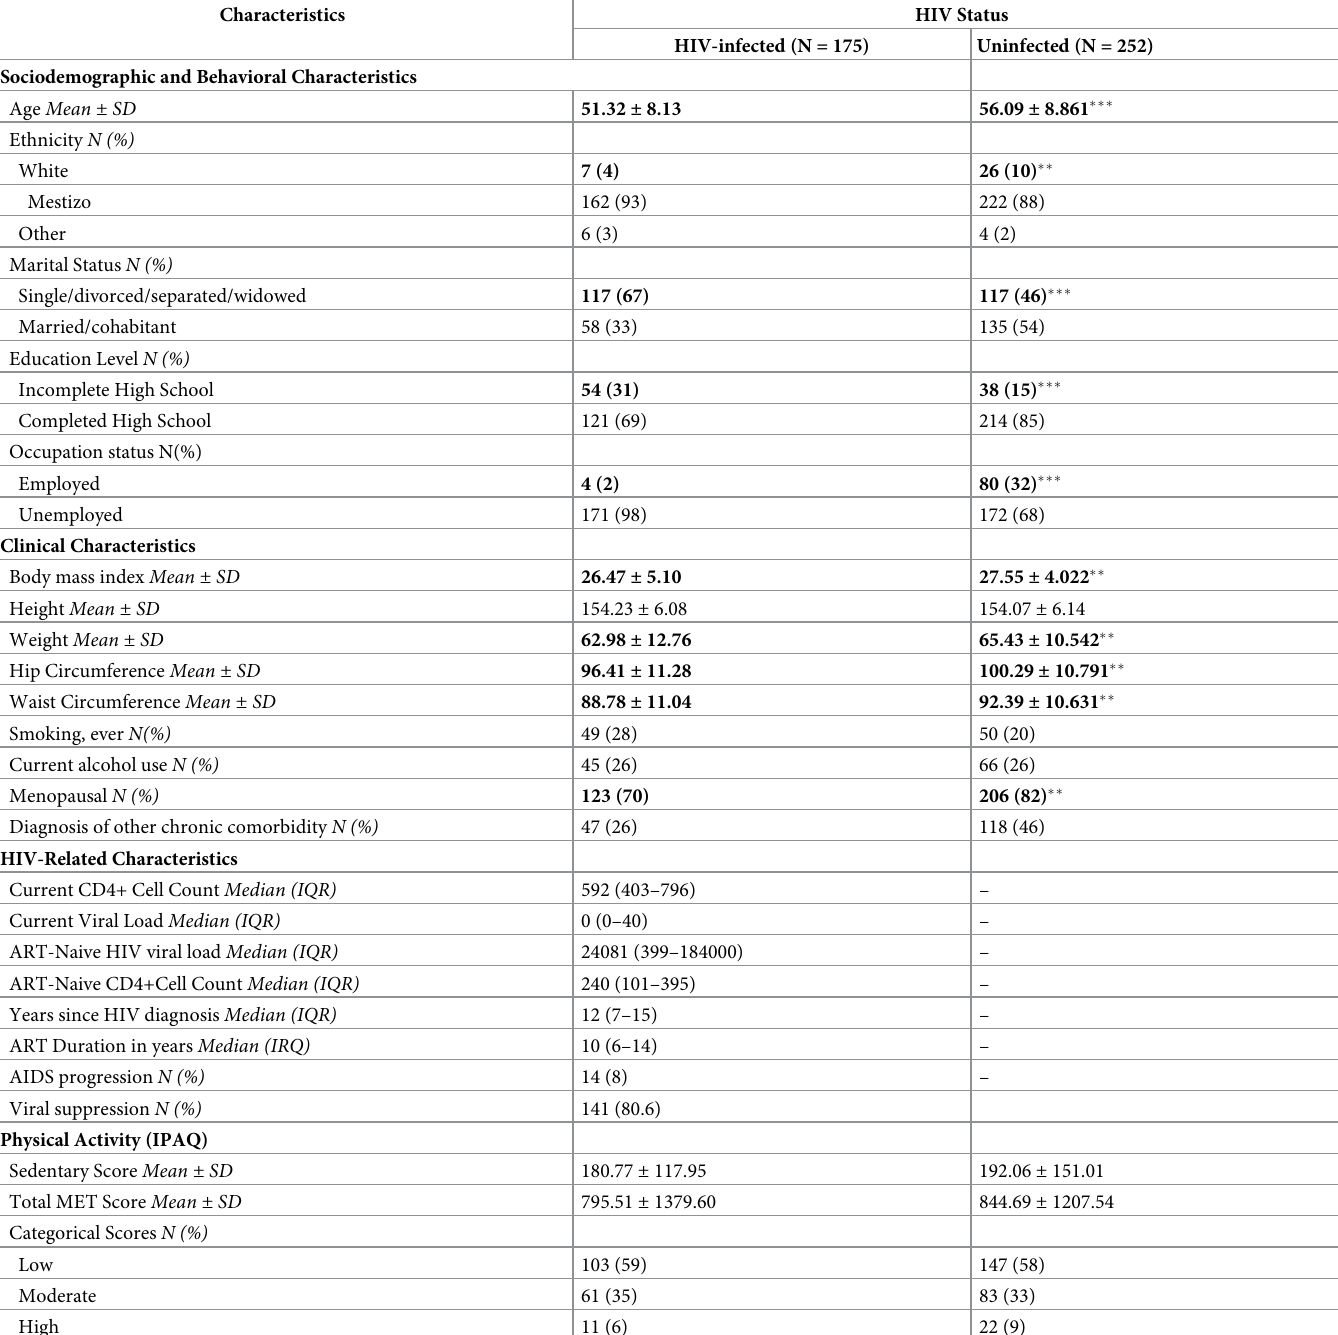
Table 1. Sociodemographic and clinical characteristics by HIV